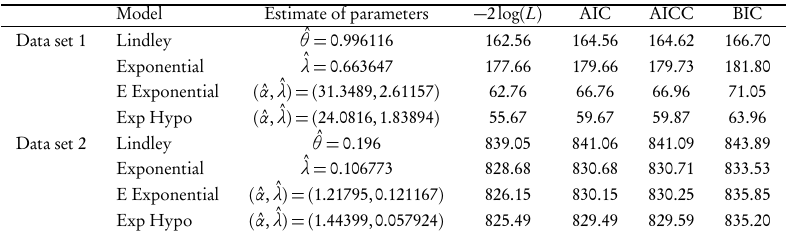
The values of − 2log ( L ) , AIC, AICC and BIC of the fitted distributions of Data sets 1 and 2. Model Estimate of parameters Data set